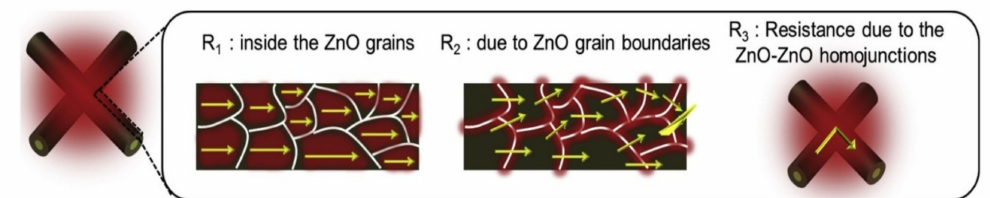
Figure 7. Effects of self-heating in SnO 2 –ZnO core–shell NWs. Reprinted from [76] with permission from